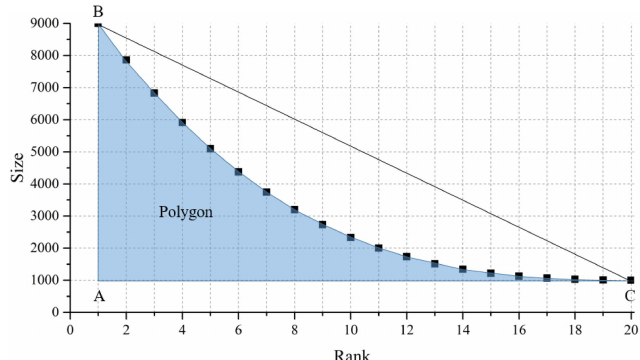
Figure 2. An example rank-size plot. Two areas in this plot are used for the calculation of the defined index. One area is the polygon filled with color, and the other one is the triangle